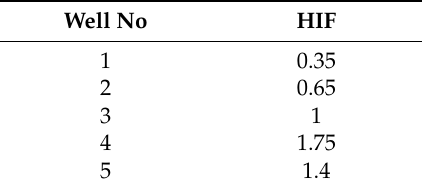
Table 4. Matched HIF per well.